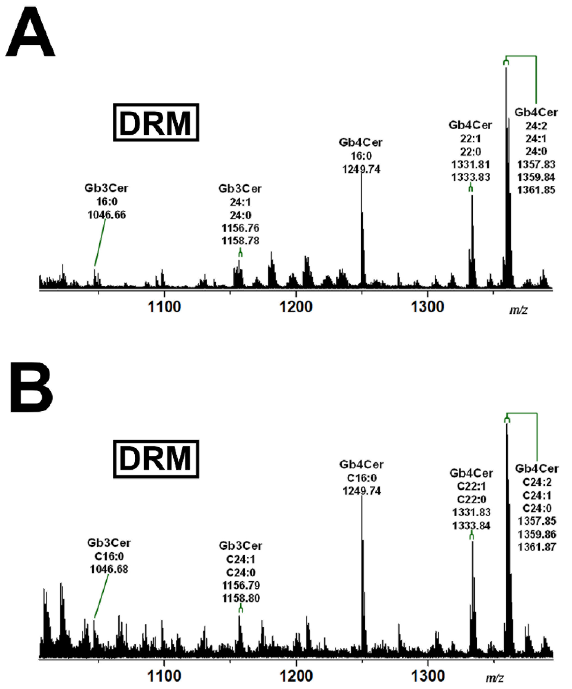
Figure 7. Overview mass spectra of the Gb3Cer and Gb4Cer lipoforms obtained from the DRM F2 fractions of pHCoEpiCs propagated in low-serum ( A ) and serum-free medium ( B ). The extended spectra of Gb3Cer and Gb4Cer in the GSL preparation of DRM fraction F2 in comparison to total GSLs derived from serum-free cultivated cells are depicted in Figure 8.